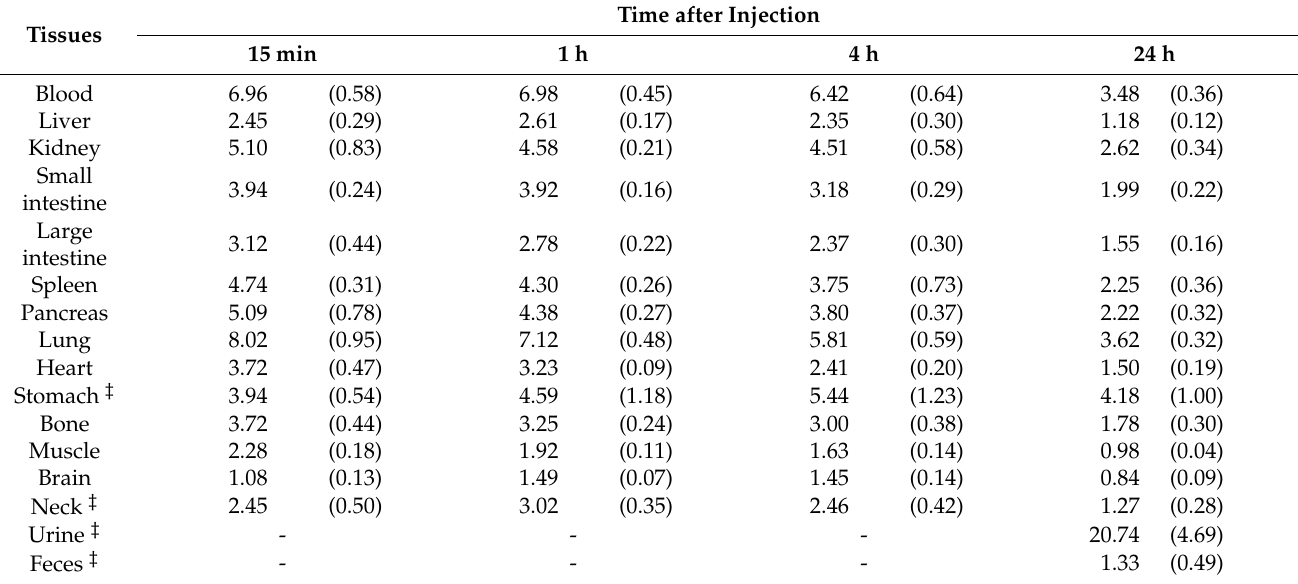
Table 4. Biodistribution of [ 77 Br]bromide at 15 min, 1, 4, and 24 h after i.v. injection in ddY